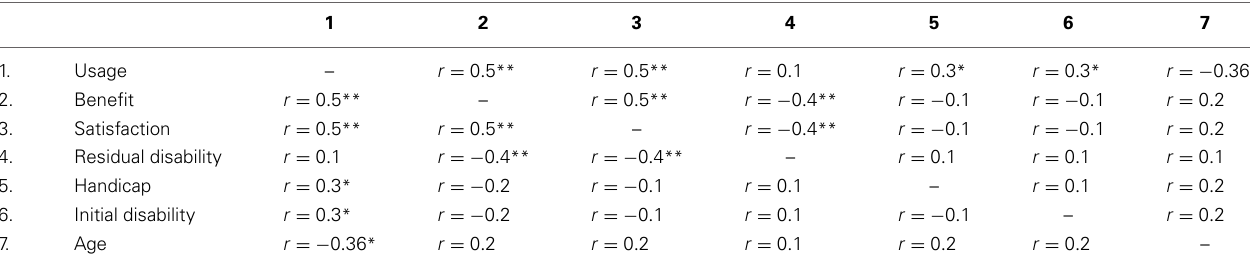
Table 3 | Results of pearson correlation for GHABP 3-month follow-up.